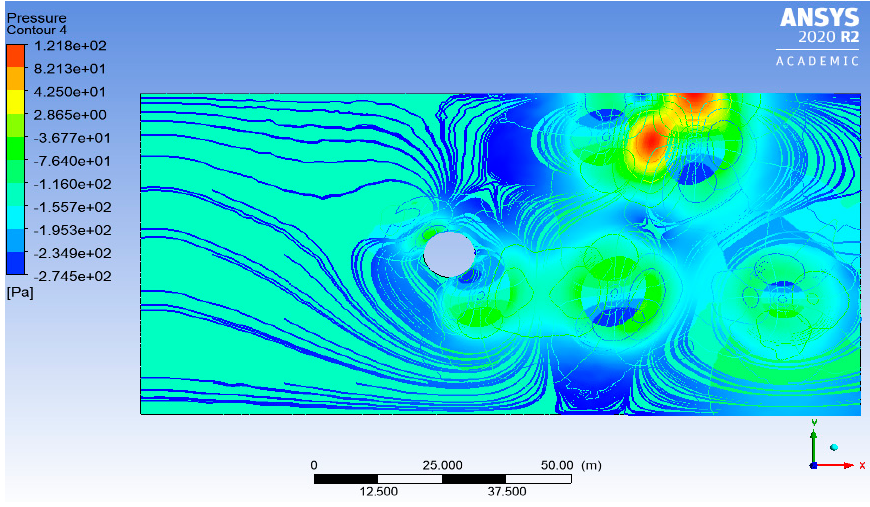
Figure 16. Pressure contour for the flow on the free-floating buoy under 0.45 m/s case.